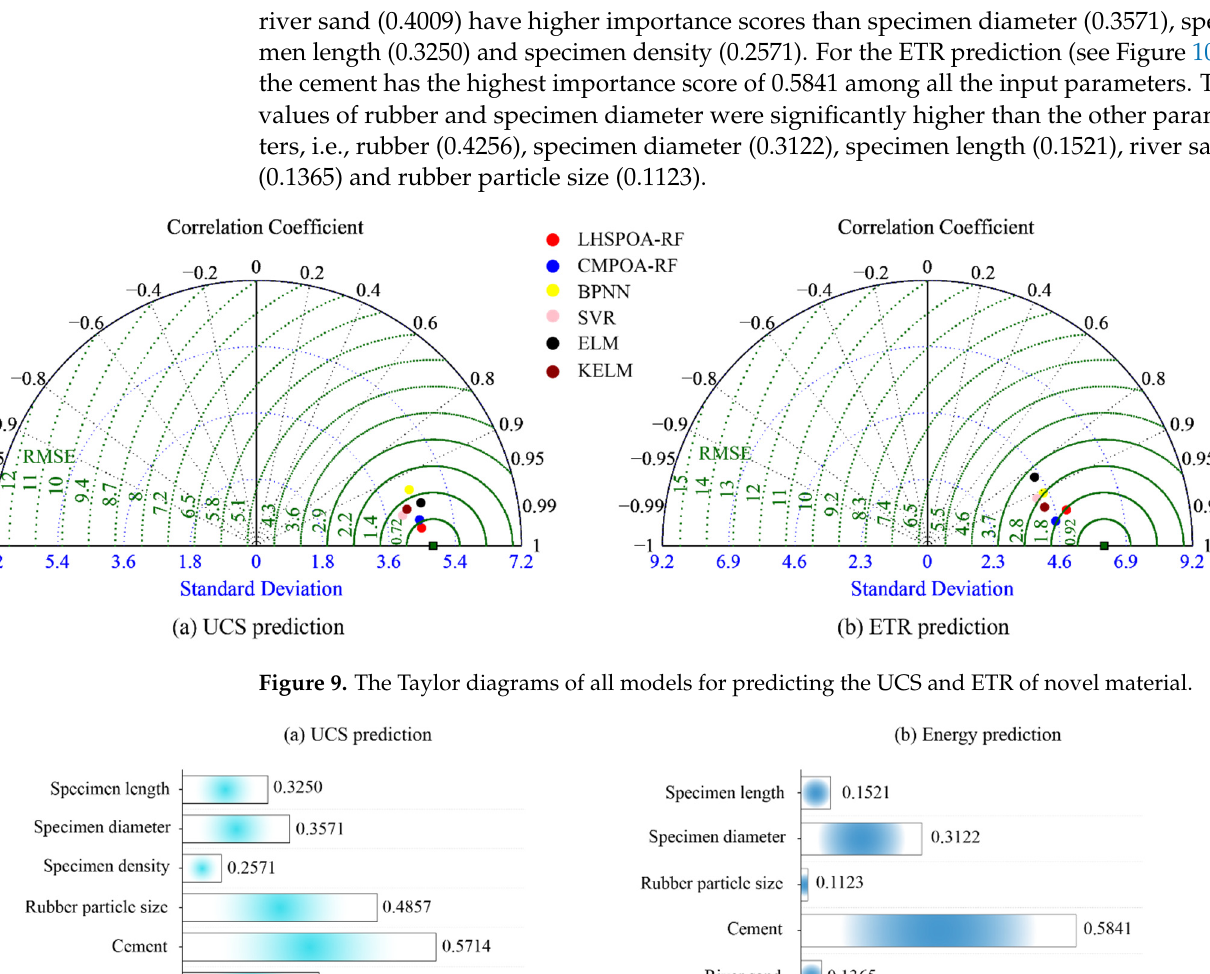
Figure 8. The performance comparison of the proposed models and four common ML models in the UCS and the ETR prediction.